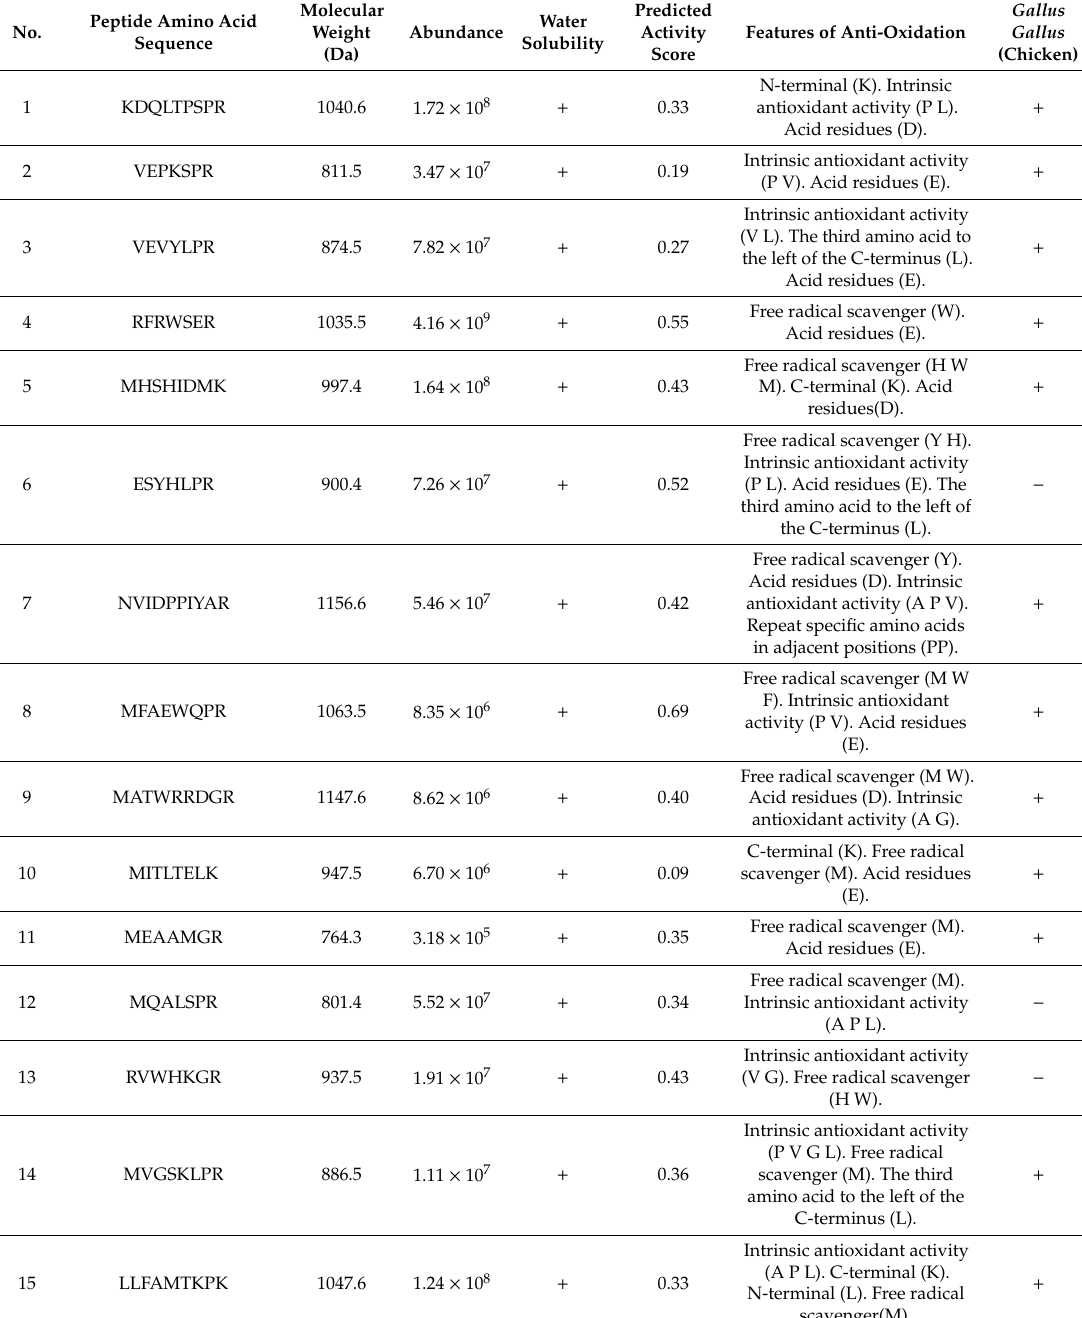
Table 2. Antioxidant peptide amino acid sequences from